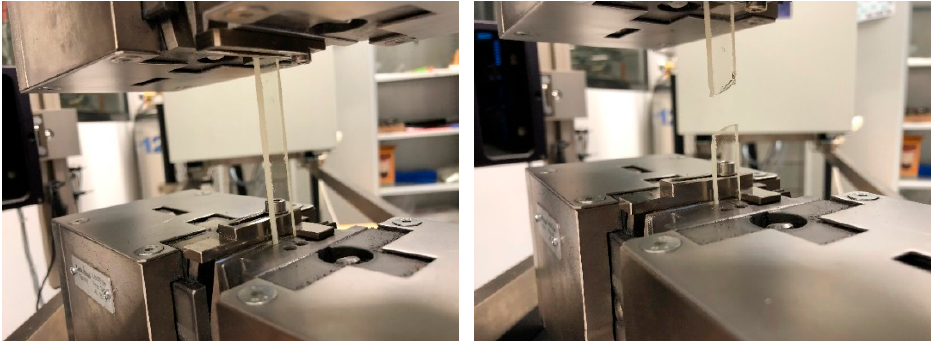
Figure 7. Exemplary samples during the mechanical tests.